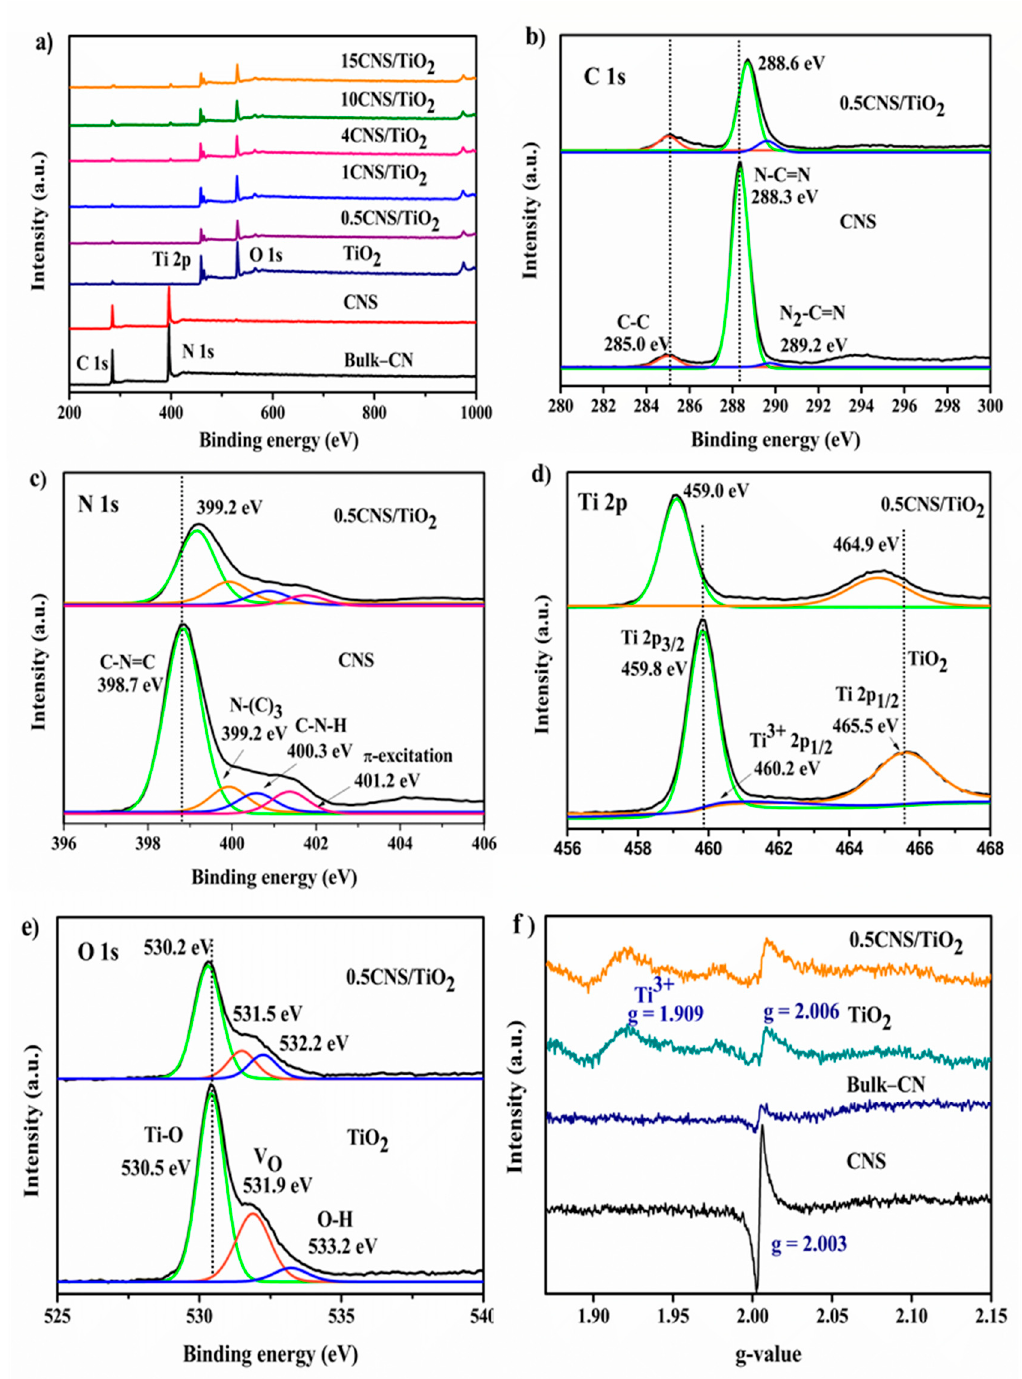
Figure 2. ) a ) The survey scan of all samples. ( b ) The C 1 s spectra. ( c ) The N 1 s spectra. ( d ) The Ti 2 p Figure 2. ( a ) The survey scan of all samples. ( b ) The C1s spectra. ( c ) The N1s spectra. ( d ) The Ti 2p spectra. ( e ) The O1s spectra. ( f ) Solid EPR spectra of g-C 3 N 4 , TiO 2 , and g-C 3 N 4 /TiO